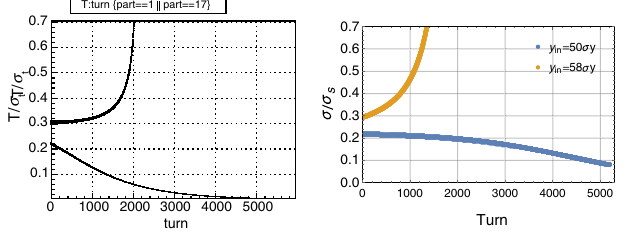
FIG. 10. Evolution of longitudinal coordinate from tracking (left) and from calculations by (30) and (31) (right) corresponding to initial conditions y ¼ 50 σ and y ¼ 58 σ and adjusted longi- y y tudinal initial conditions (30) and (31).